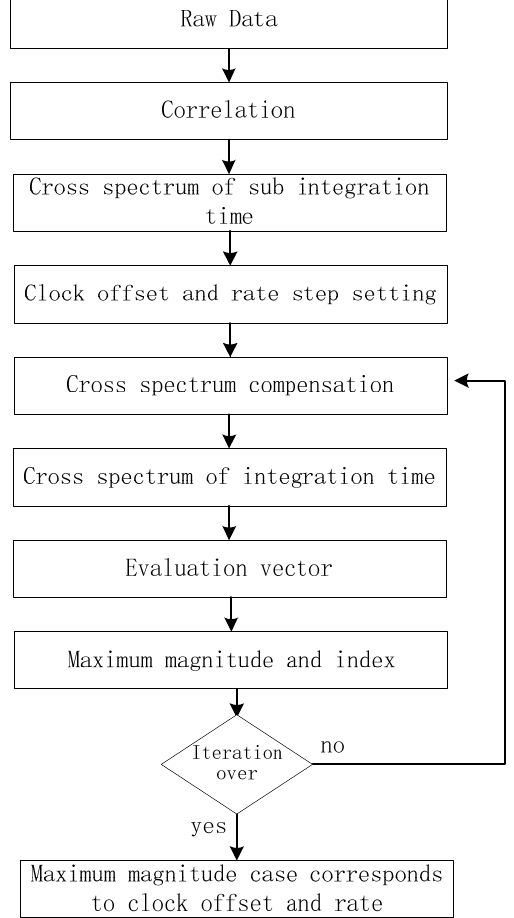
Figure 5. Flow scheme of clock estimation method.